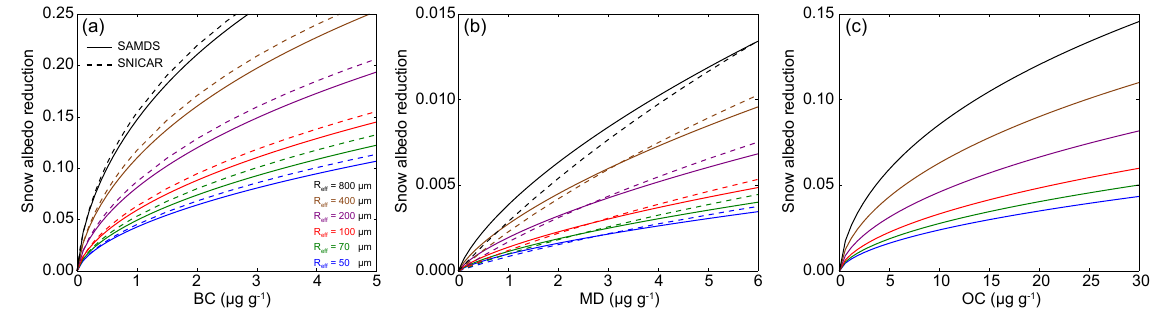
Figure 9. Spectrally weighted snow albedo reduction over the 400–1400nm solar spectrum attributed to (a) BC, (b) MD, and (c) OC computed as the albedo of pure snow minus the albedo of contaminated snow for a 60 ◦ solar zenith angle. Solid and dashed lines show the SAMDS and SNICAR model predictions. The MAC values of BC, OC, and Fe were assumed to be 7.5, 0.3, and 0.9m 2 g − 1 at 550nm, respectively, in the SAMDS model.